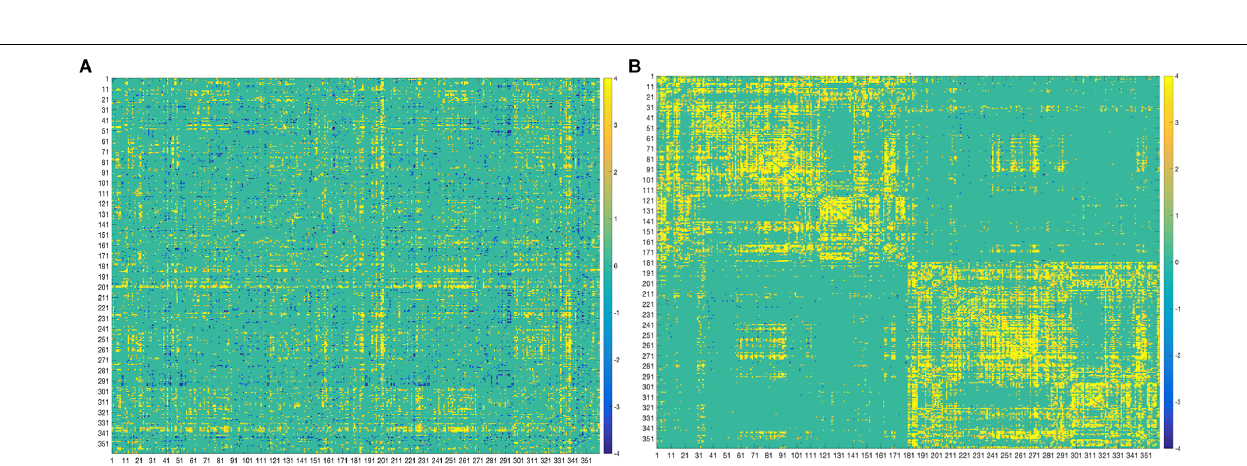
insular and frontal opercular cortex and several other regions: left paracentral lobular and mid cingulate cortex